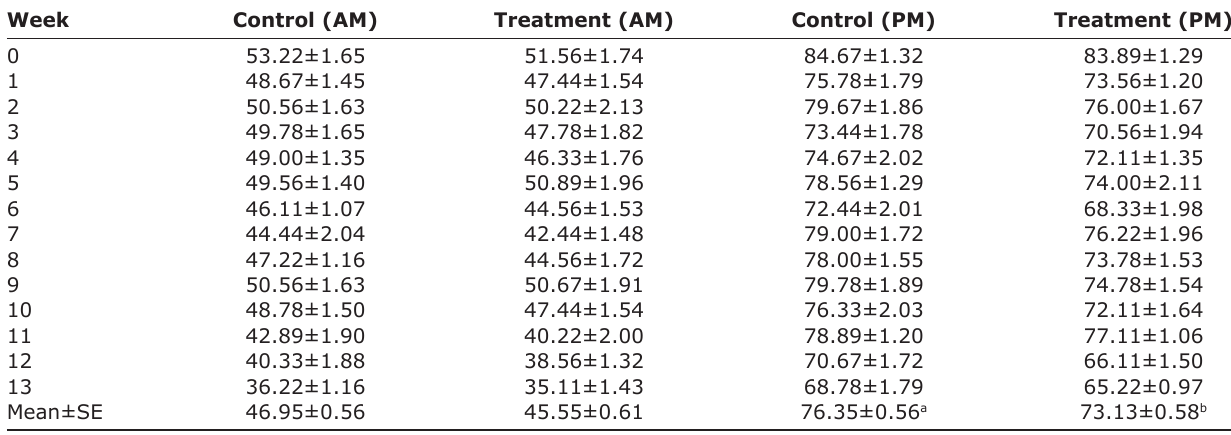
Table-4: Weekly morning (AM) and afternoon (PM) respiration rate (breaths/min) in KF Heifers. Week Control (AM) Treatment (AM) Control